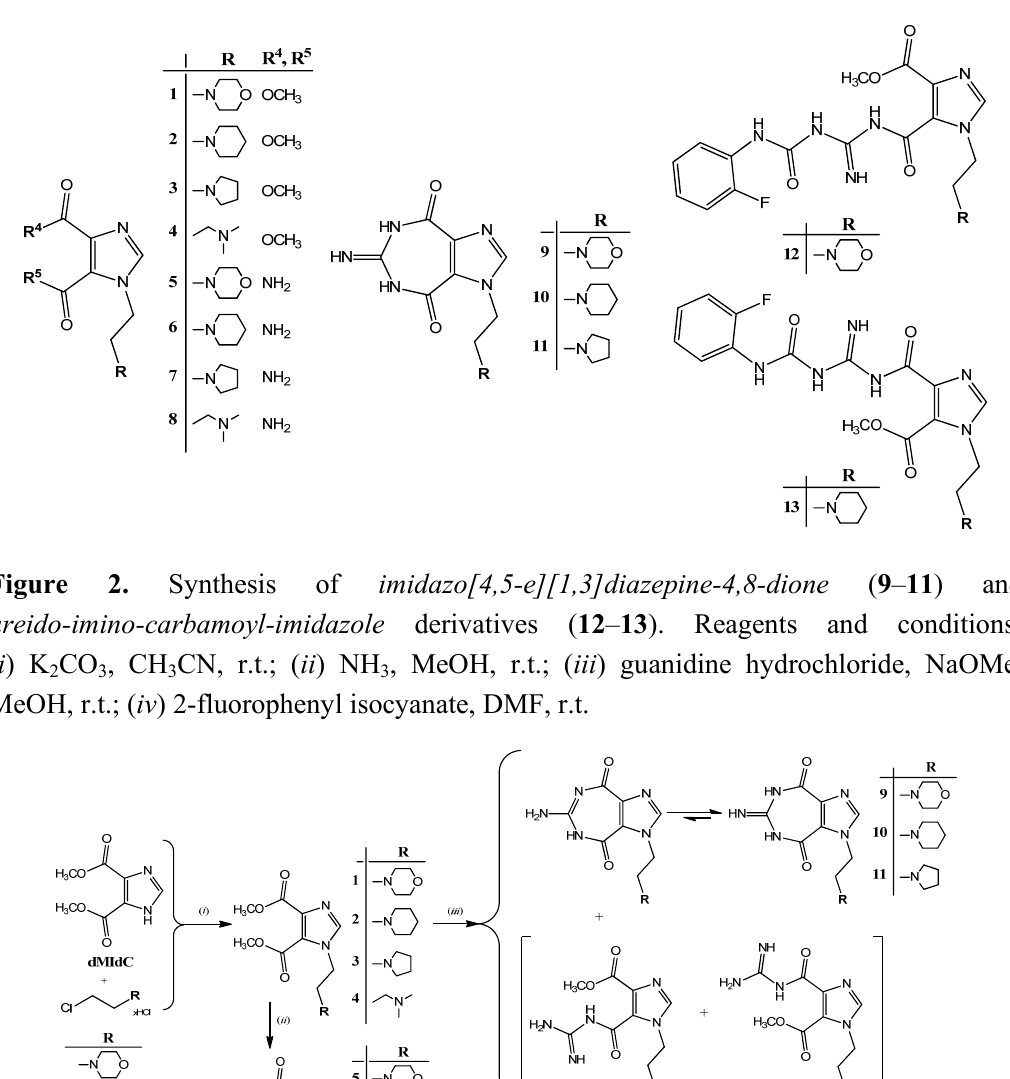
Figure 1. New 1 H -imidazole-4,5-dicarboxylic acid/amide derivatives ( 1 – 8 ), imidazo[4,5-e][1,3]diazepine-4,8-dione derivatives ( 9 – 11 ) and carbamoyl imino-ureido derivatives of imidazole ( 12 and 13 ).